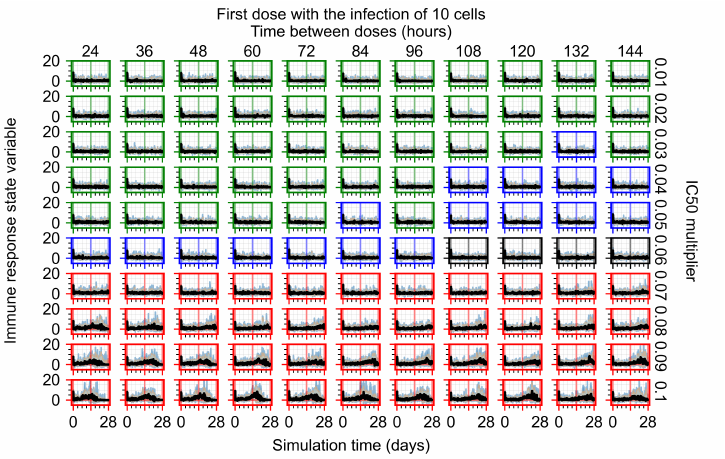
Figure A12. Amount of viral RNA in infected cells (arbitrary units), Y axis in log scale, and exponent values as tick marks.